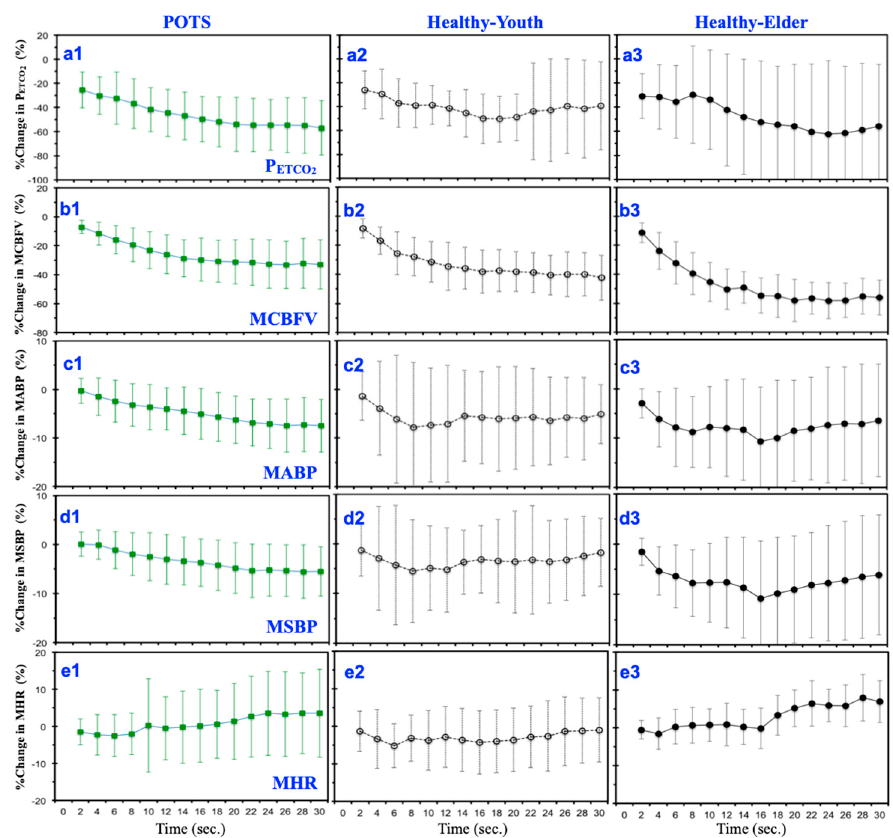
Figure 3. Mean percentage changes in P ETCO 2 ( a1 – a3 ), MCBFV ( b1 – b3 ), MABP ( c1 – c3 ), MSBP ( d1 – d3 ), and MHR ( e1 – e3 ) under an initial 30 s of hyperventilation (15 breathing cycles) for the three groups: